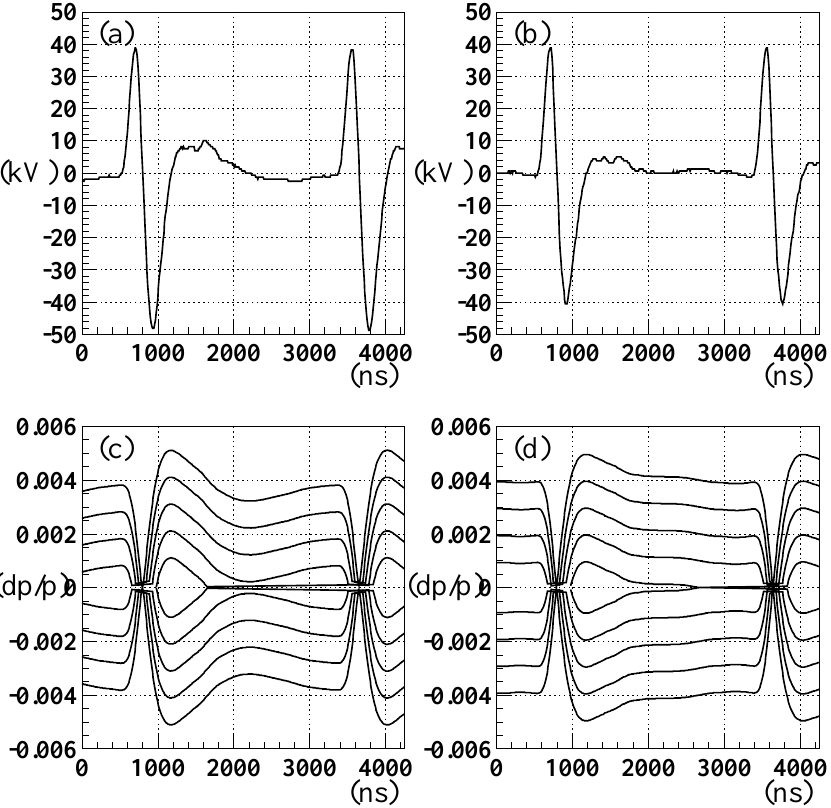
FIG. 6. Gap voltages (a),(b) and the rf buckets (c),(d). Waveform (a) was used in the experiment, which forms the rf bucket (c). The waveform (b) and the bucket (d) were